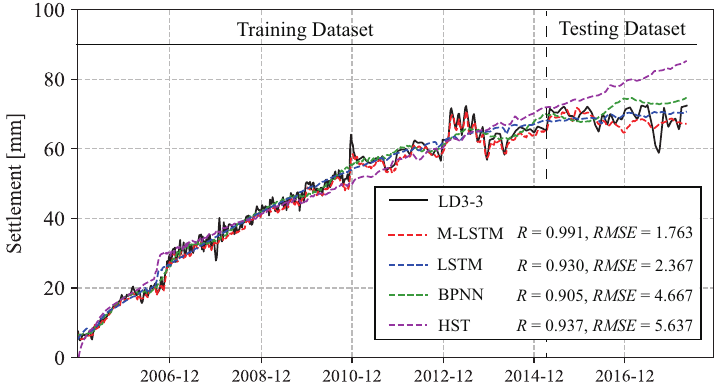
Figure 13. Fitting and prediction results of four models for